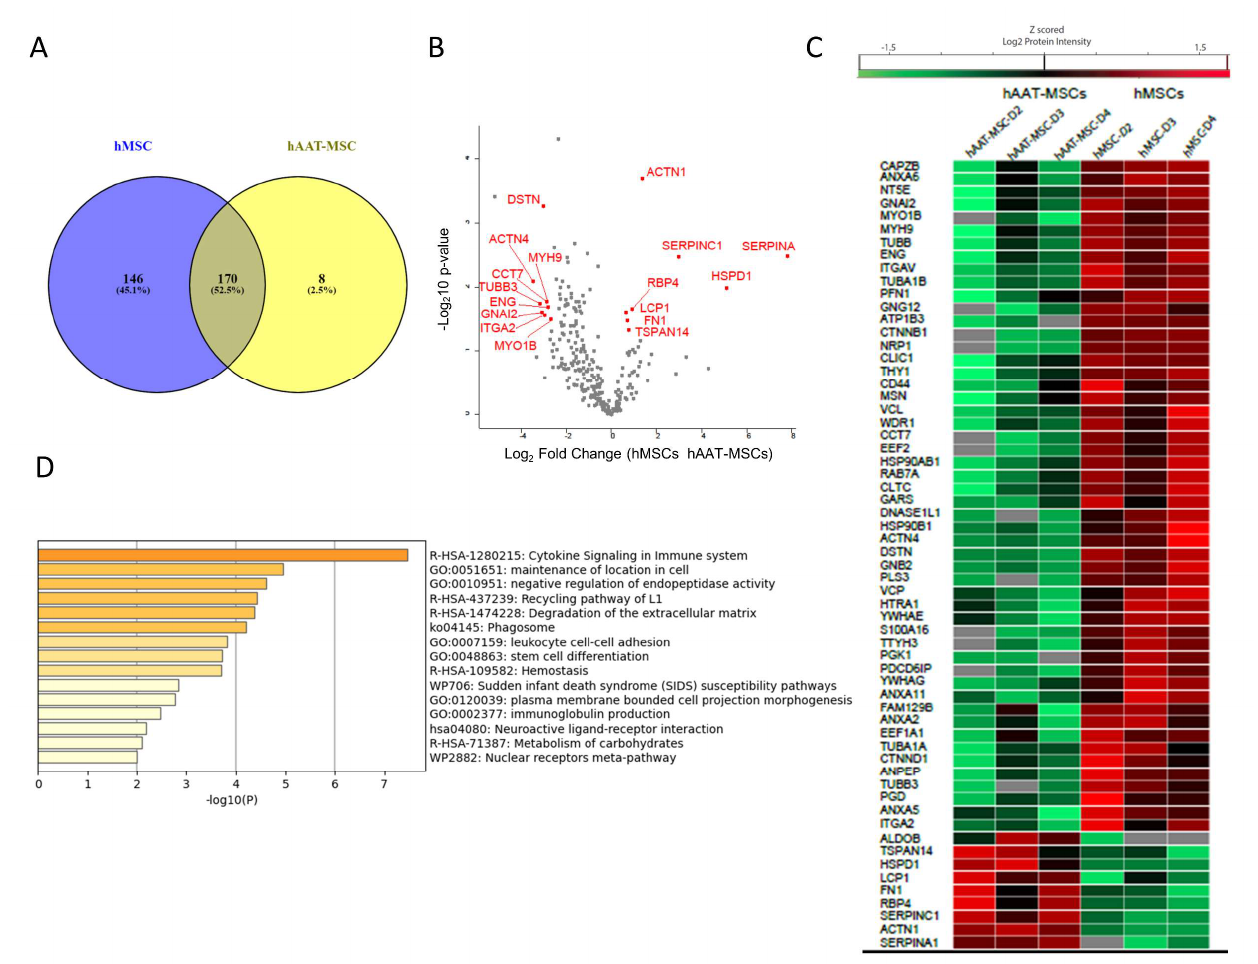
Figure 4. Horizontal bioinformatics analysis of exosomal proteins of hMSCs and hAAT-MSCs. ( A ) Venn diagrams of exosome proteins from hMSCs and hAAT-MSCs. ( B ) Volcano plot of differential proteins found in hMSC exosomes vs AAT-MSC exosomes. ( C ) Heat map of the shared exosomal proteins with significant differences ( p < 0.05) in logarithmic Z score of the Protein intensity from hMSCs and hAAT-MSCs. Differences were compared by Student’s t -test. ( D ) Metascape functional enrichment of the shared proteins with significant difference from hMSCs and hATT-MSCs.